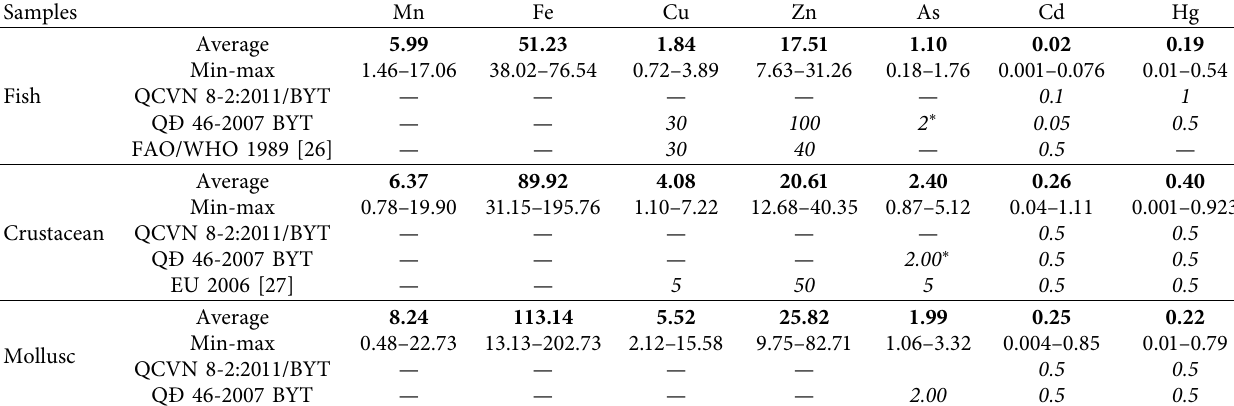
Table 4: Average (min-max) values of heavy metal contents (mg · kg − 1 ) in fish, crustacean, and mollusc samples. Samples